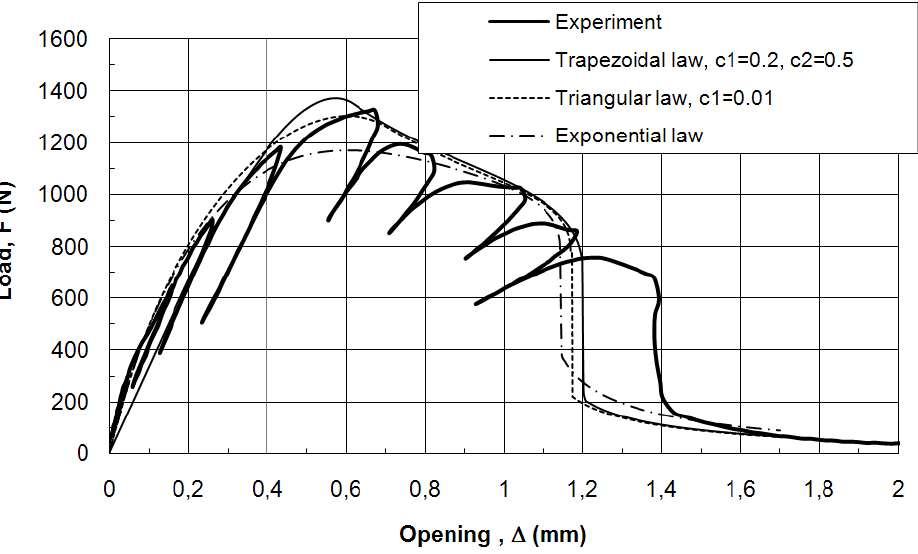
Figure 5: Tuning of ACZ model on DCB